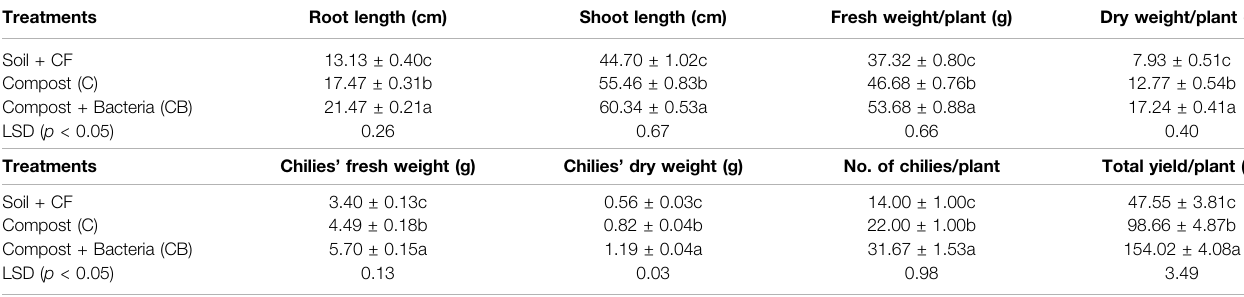
TABLE 4 | The combined impact of wheat and rice composts (mixed as 1:1) with/without PGPR consortium on chili growth and yield in pots. Treatments